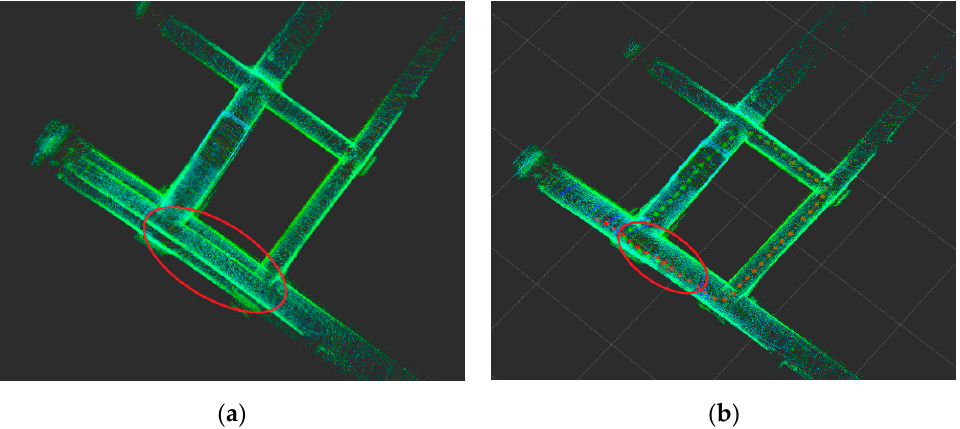
Figure 14. Effect of loop detection constraints on localization and mapping in pose graph. ( a ) Without loop detection, ( b ) with loop detection.